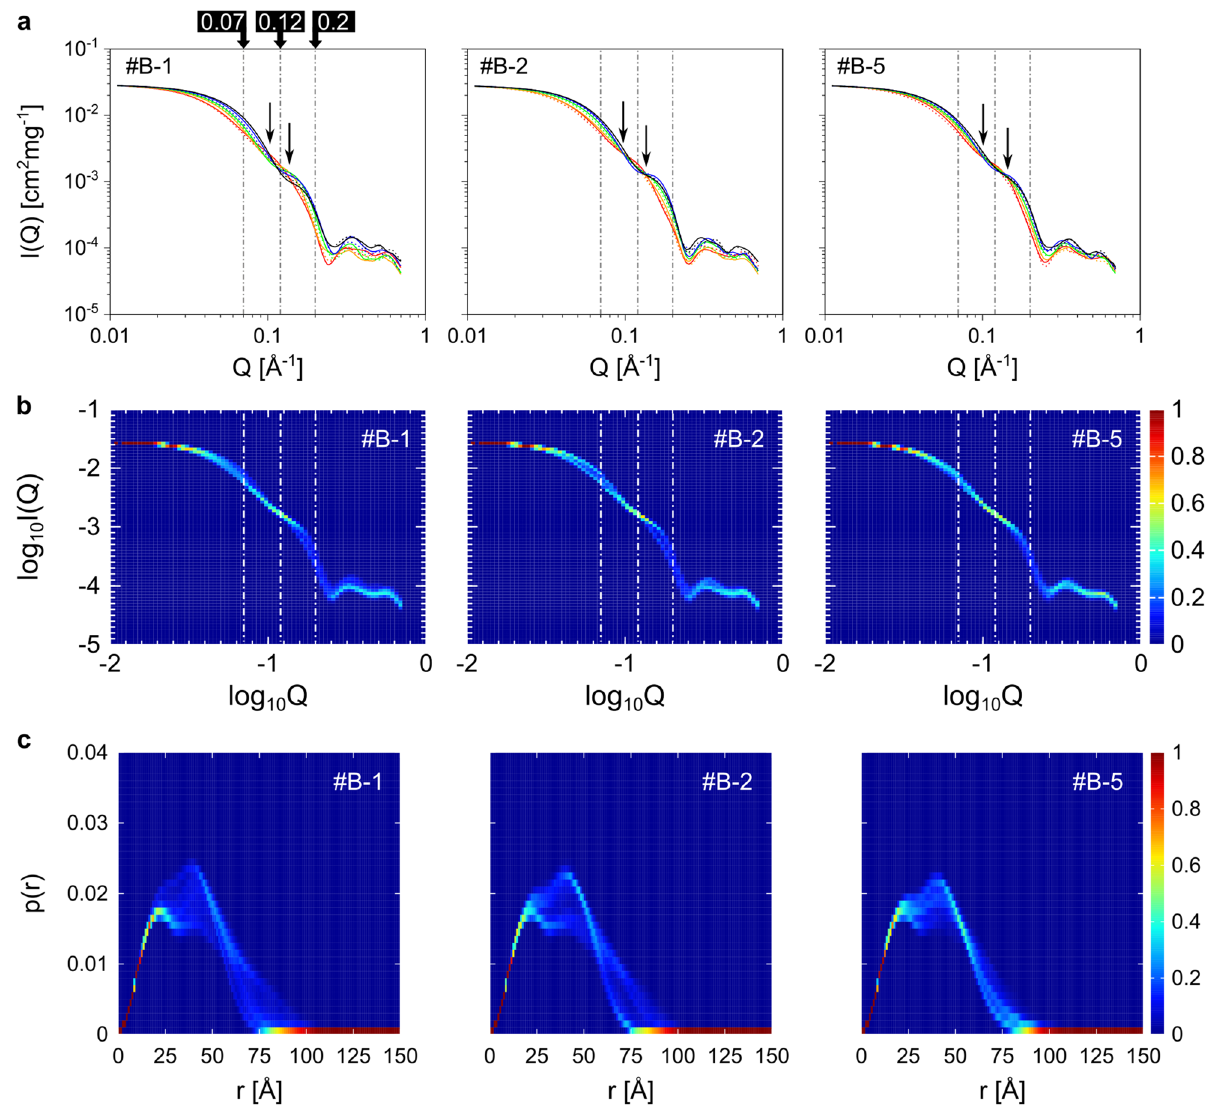
Figure 6. Variety of calculated SAXS profiles in each clipped time series. ( a ) Calculated SAXS profiles of each ER-60 structure. Ten profiles are shown for each time series. Five of them are shown by the red, orange, green, blue, and black dotted lines, respectively. The other five profiles are shown by the solid red, orange, green, blue, and black lines, respectively. For each graph, two approximate isosbestic points are shown by arrows. ( b ) Distributions of I(Q)s over all structures in each time series. The distribution is calculated for each value of log 10 Q. Therefore, for each log 10 Q, sum of the probabilities of log 10 I(Q) is 1. The color shows the appearance probability of log 10 I(Q) values at each log 10 Q. ( c ) Distribution of p(r) for each value of r. Distributions of p(r)s over all structures in each time series are shown. For each r, sum of the appearance probabilities of p(r) is 1. The color shows the appearance probability of p(r) at each r. Here, data are shown for the #B-1, #B-2, and #B-5. Data for the other time series are shown in the Supplementary Figure